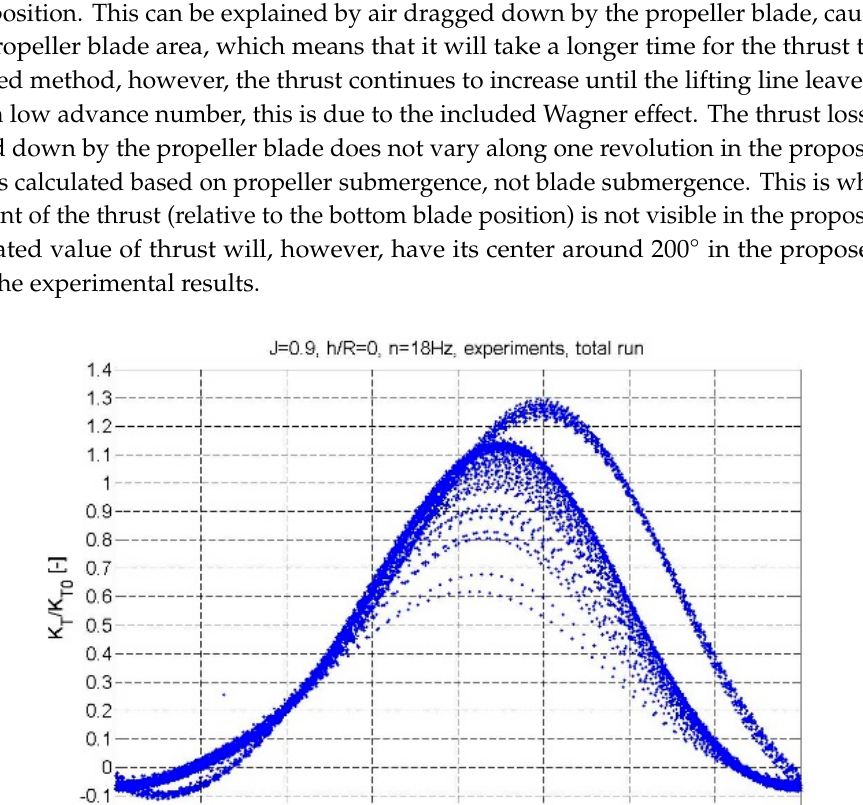
Figure 16. Calculation of thrust loss factor as a function of blade position.